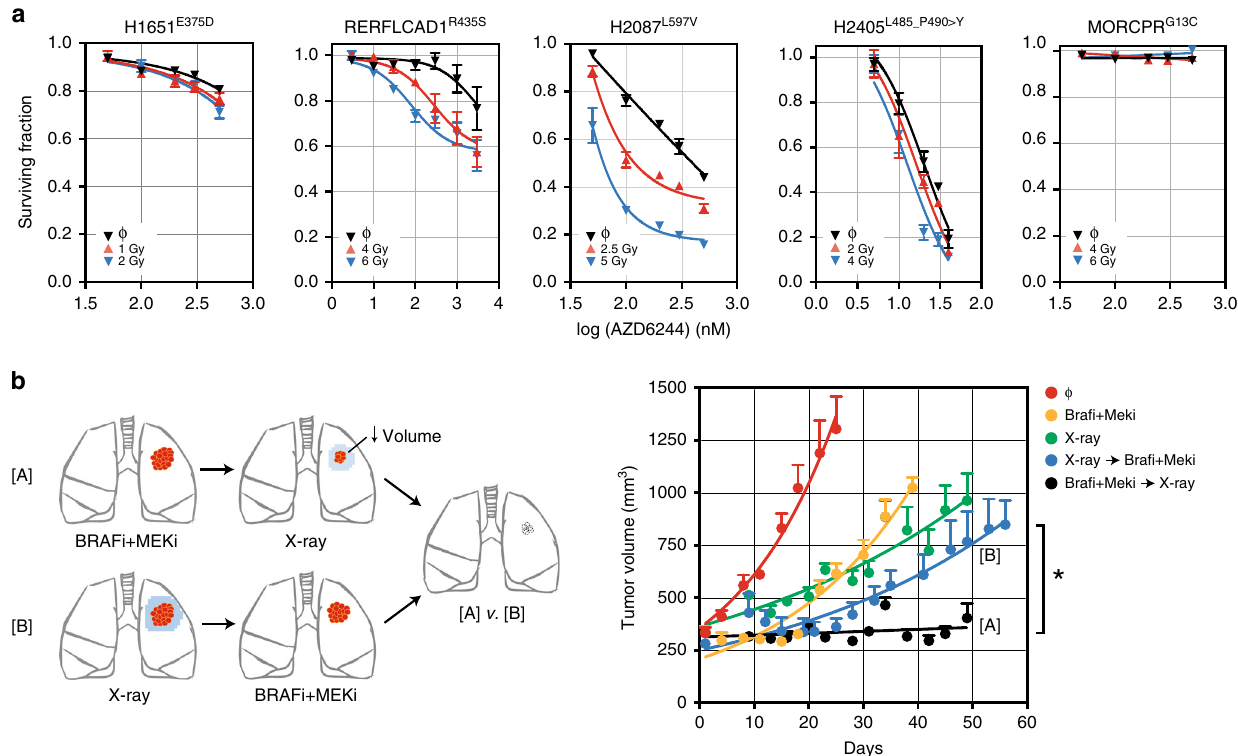
Fig. 7 Optimal therapeutic strategies for categories of hypermorphic BRAF variants in LUAD. a Cells were incubated with AZD6244 for 24 h and treated as control (0 Gy) or with radiation. Survival is measured by proliferation assay. Data points represent mean ± s.e.m. b Schematic depicting sequential treatment strategies for hyperactivating mutations in BRAF . NSG mice bearing LUAD PDX with V600E mutation in the fl ank were block randomized into one of fi ve treatments arms as shown. Dabrafenib and trametinib were given together for 14 days. Radiation (X-ray) was delivered over three consecutive days to a total dose of 6 Gy. Sequential treatments were given at least 24 h after the completion of the fi rst therapy. Data are expressed as the mean ± s.e. m; n = 5 independent animals for each arm. The P -value of the χ 2-test between [A] and [B] was